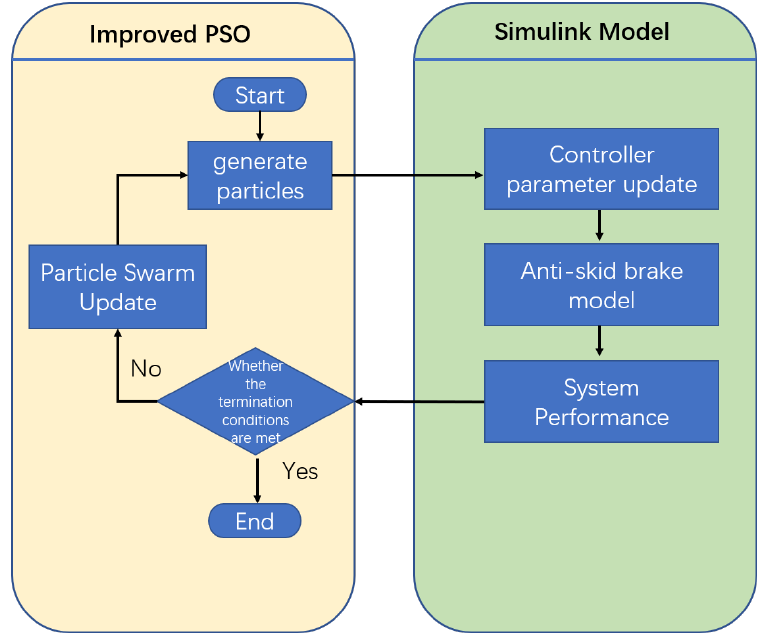
Figure 7. Flow chart of particle swarm